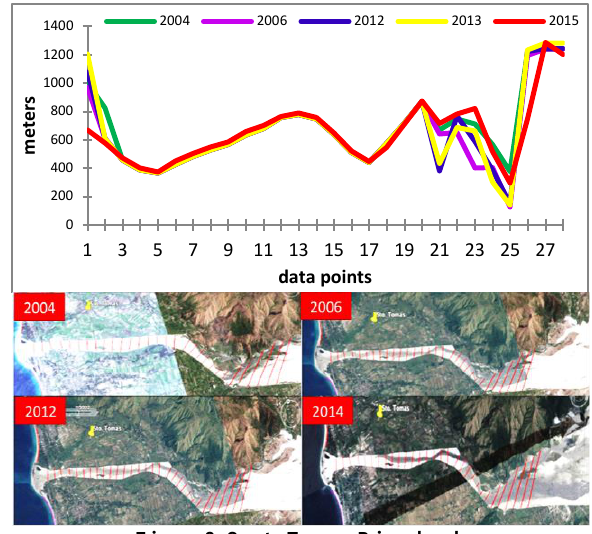
Figure 8. Santo Tomas River bank